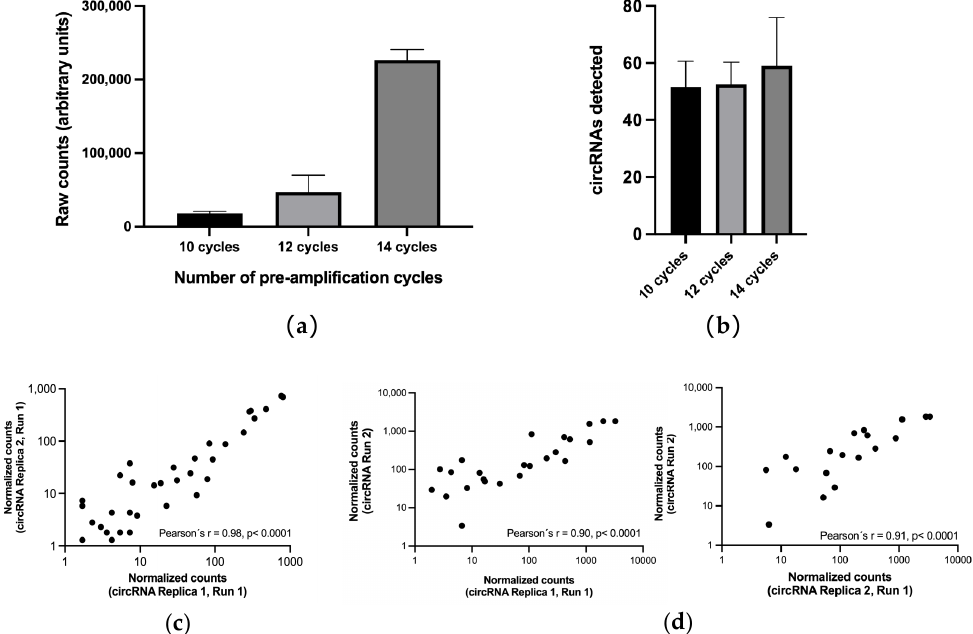
Figure 3. Testing of a different number of pre-amplification cycles. Effect of the number of pre- amplification cycles (10, 12 and 14) on ( a ) the total number of raw counts and ( b ) total number of circRNAs detected. Error bars indicate standard deviation; ( c ) Correlation of the two technical nCounter duplicates subjected to 10 cycles of pre-amplification. Pearson’s correlation coefficient is indicated. ( d ) Correlation of each of the technical duplicates from the same nCounter run with the results obtained in an independent nCounter assay of the same sample. Pearson’s correlation coefficient is